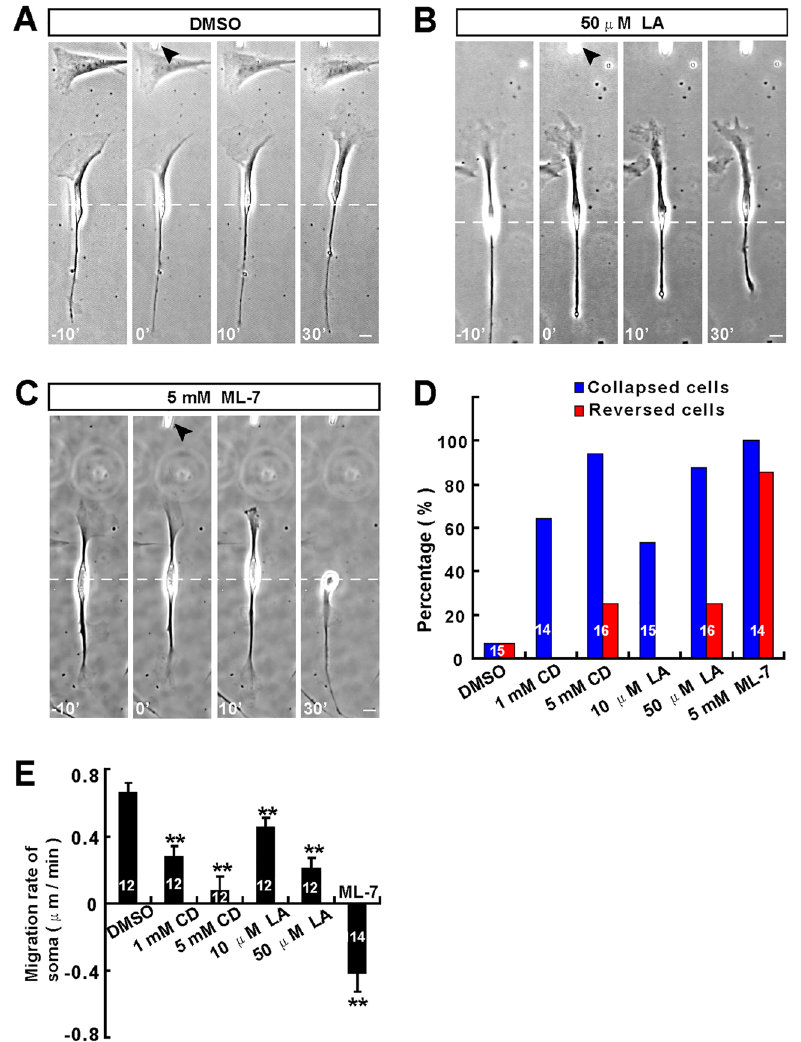
Figure 4. Decreasing the front-to-rear difference of myosin II activity induced the collapse of lead front and reversal of soma translocation of Schwann cell-like OECs. ( A–C ) Images of migrating Schwann cell-like OECs before and after the frontal application of a gradient of DMSO as a control ( A ), latrunculin A (LA, 50 μ M in micropipette, B ) or ML-7 (5 mM in micropipette, C ). ( D–E ) Summary of the percentages of collapsed or reversed cells in total observed cells ( D ) and migration rates of the soma ( E ) under various conditions. White arrowheads indicated the direction of the micropipette. Time, min; scale bars, 20 μ m. Data were mean ± SD. ** P < 0.01 , compared with control, Student’s t